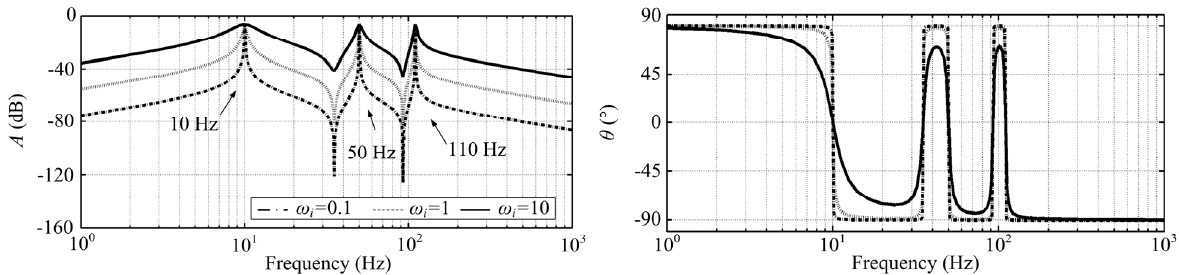
Figure 6. Open loop Bode plot of resonant controller.